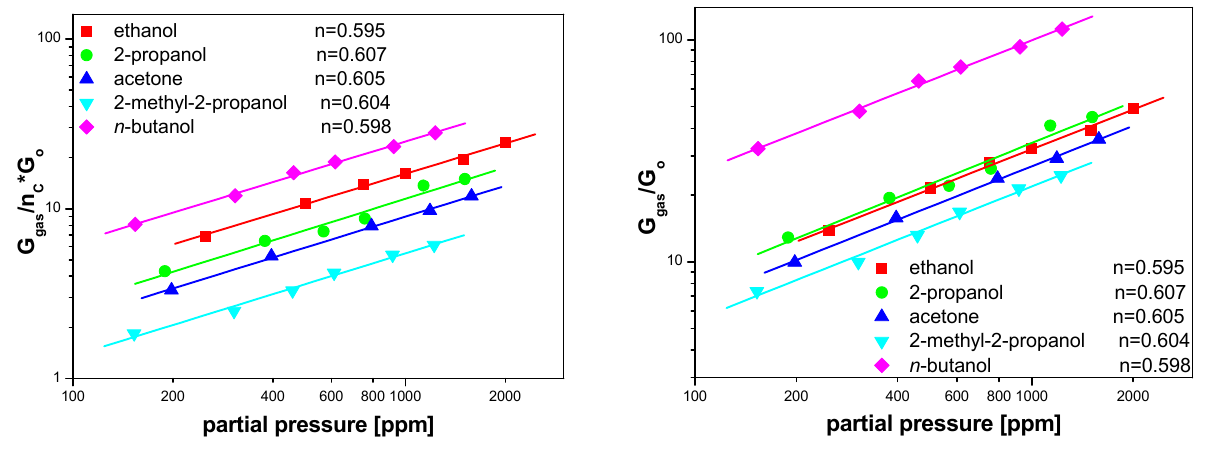
Figure 8. Modified sensitivity dependence versus partial pressure of